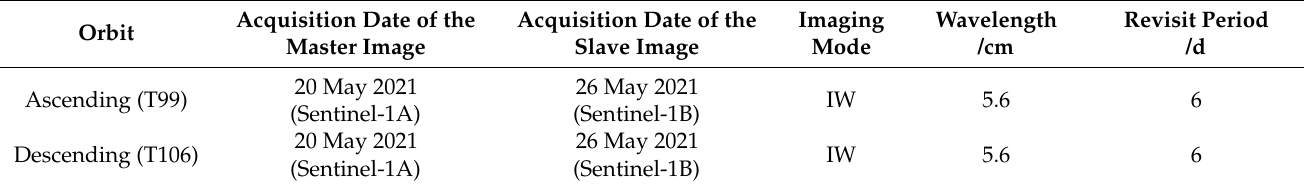
Table 1. The information of the used SAR satellite data.